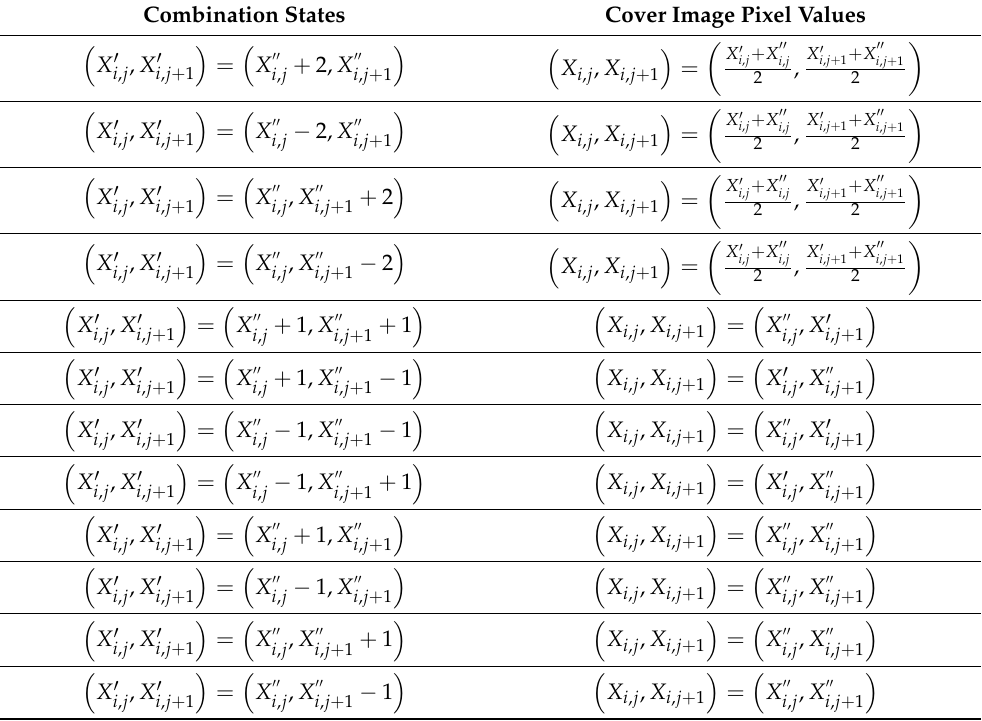
Table 2. Combination states and cover image pixel values for the data extraction